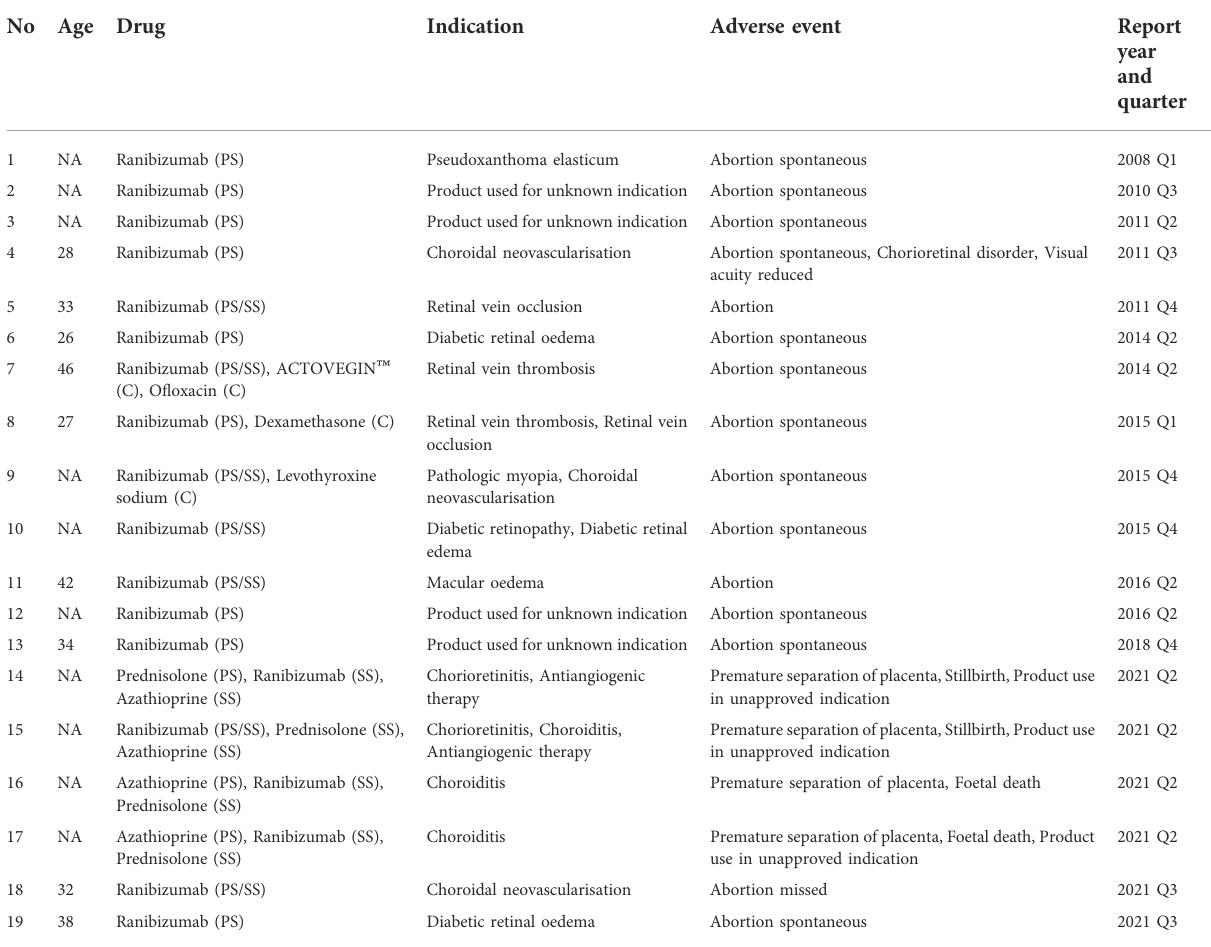
TABLE 4 Individual case safety reports of pregnancy loss with ranibizumab. No Age Drug